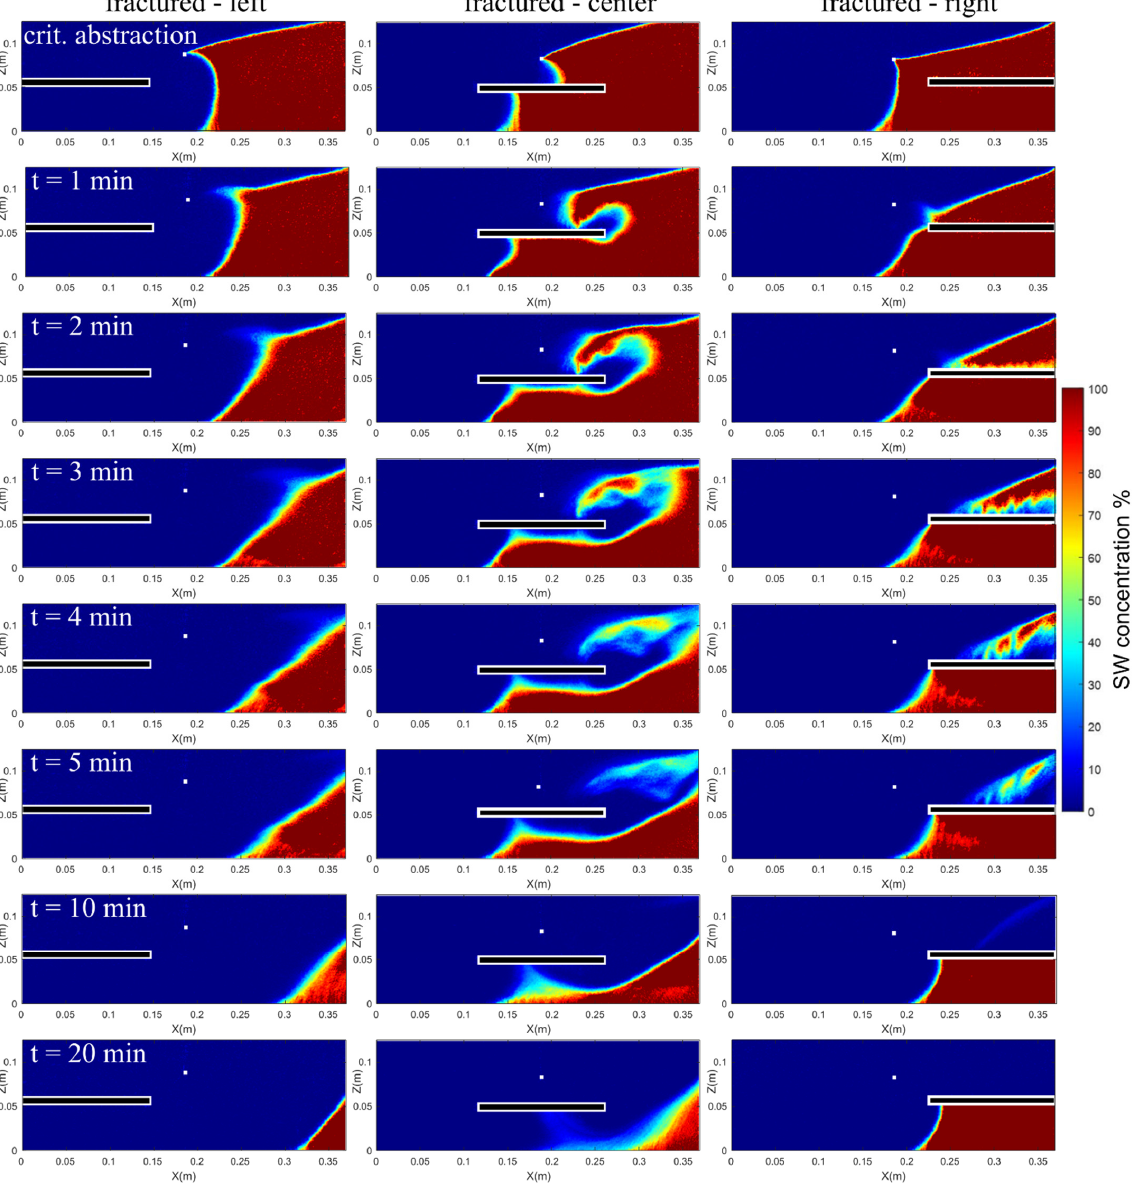
Figure 7. Experimental saline concentration fields generated during the saltwater retreat phase in the fractured-left, the fractured-center and the fractured-right synthetic aquifers.